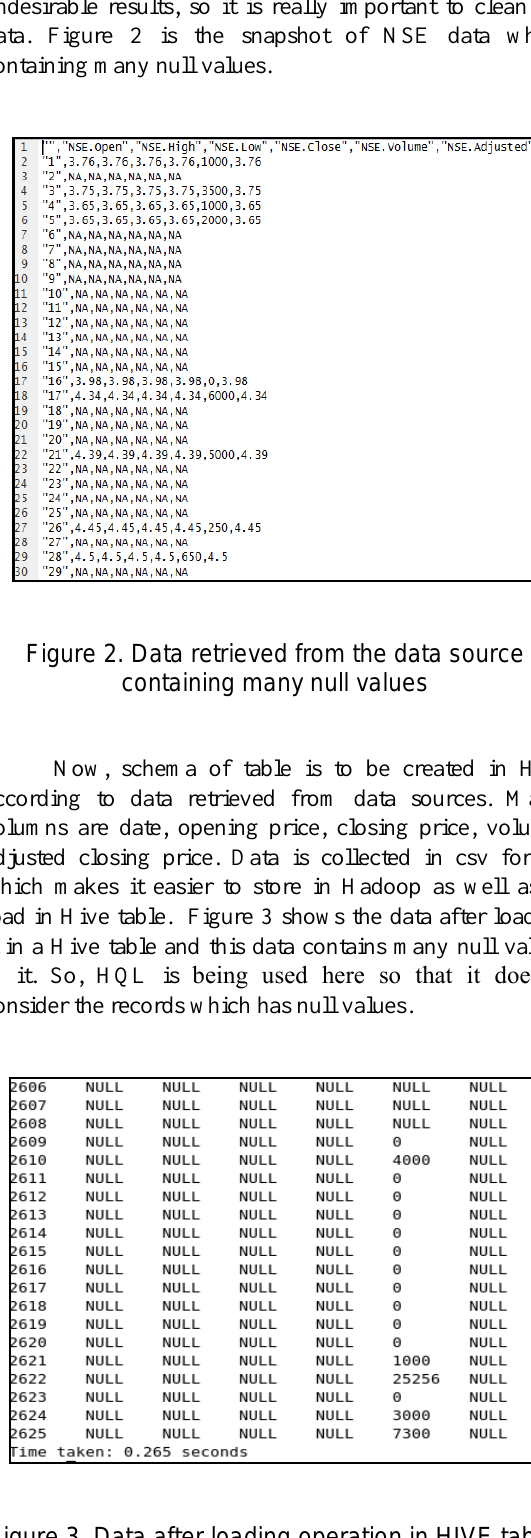
Figure 3. Data after loading operation in HIVE table, showing NULL values